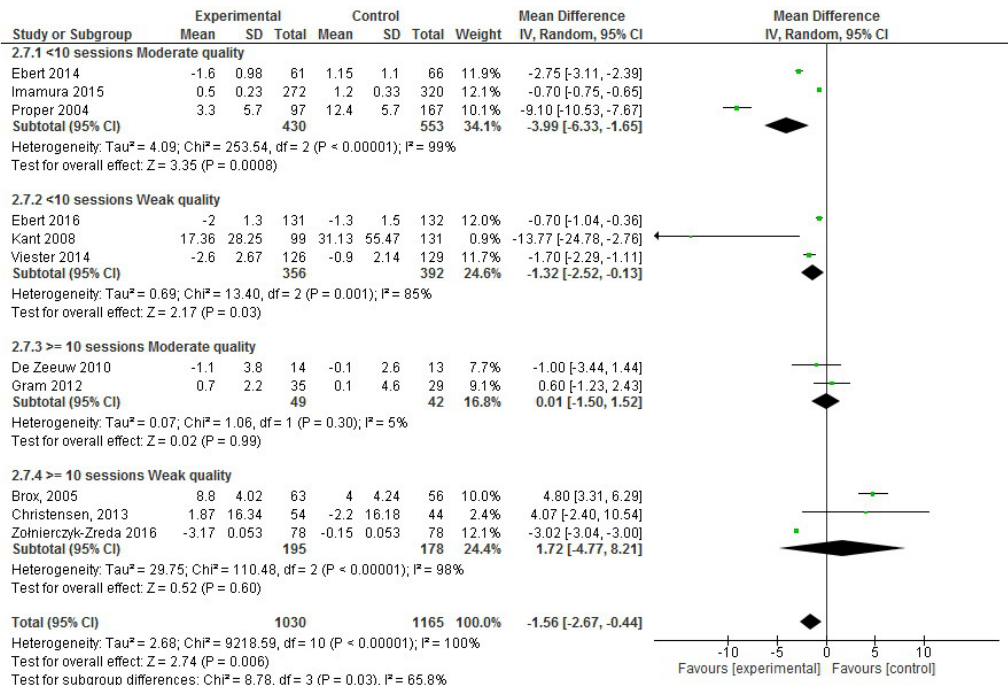
Figure 4. Forest plot for the effectiveness of workplace interventions for reducing absenteeism according to the number of intervention sessions and the quality of the studies.